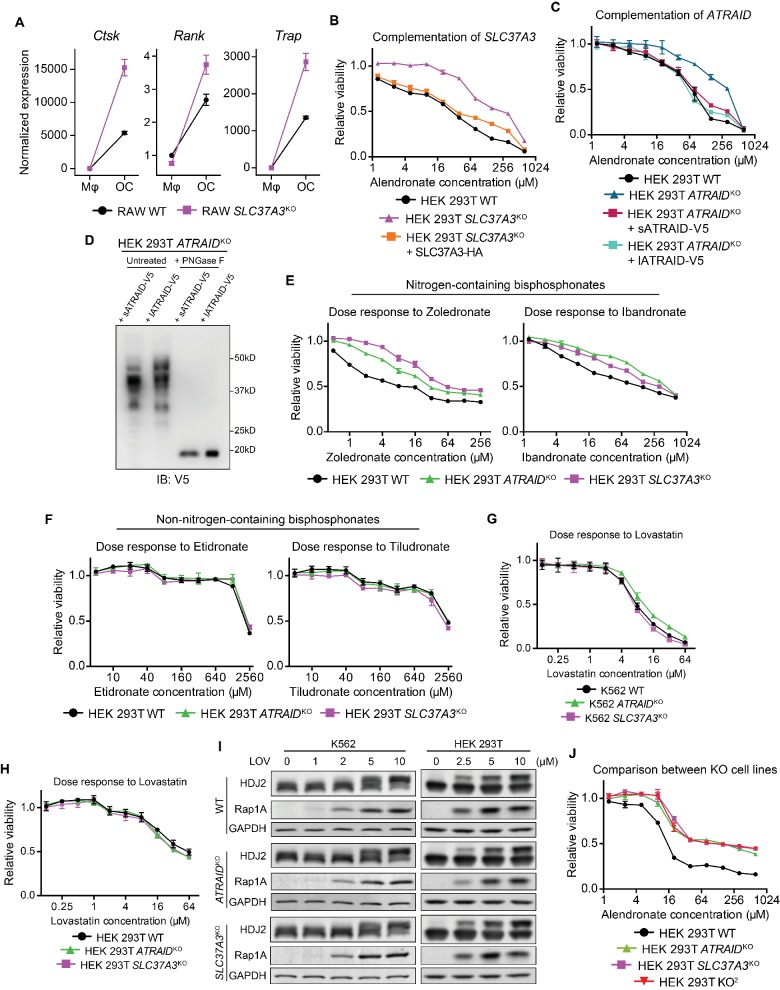
Additional evidence that validates SLC37A3 and ATRAID as functionally related genes required for the mechanism of action of N-BPs.(A) Expression of osteoclast markers (Ctsk, Rank and Trap) in undifferentiated RAW macrophages (Mφ) and differentiated RAW osteoclasts (OC), demonstrating successful differentiation of RAW cells. (B–C) Dose responses to alendronate in SLC37A3KO or ATRAIDKO HEK 293 T cells complemented with epitope tagged SLC37A3 or ATRAID, respectively, compared with those in wild-type, ATRAIDKO and SLC37A3KO cells. (D) Immunoblot comparing the short isoform of ATRAID (sATRAID) with the long isoform of ATRAID (lATRAID), showing that the long isoform of ATRAID is expressed as the same protein as the short isoform of ATRAID. Note that unequal amount of protein was loaded in each lane to obtain even exposure. The amount of protein loaded from left to right was: 100 µg, 40 µg, 10 µg and 4 µg, respectively. (E–F) Dose response curves of wild-type, ATRAIDKO and SLC37A3KO HEK 293 T cells to nitrogen-containing bisphosphonates (E) and non-nitrogen-containing bisphosphonates (F). (G–H) Dose response curves of wild-type, ATRAIDKO and SLC37A3KO K562 cells (G) and HEK 293 T cells (H) to lovastatin. (I) Immunoblots measuring lovastatin-induced reduction in protein prenylation in wild-type, ATRAIDKO and SLC37A3KO K562 cells and HEK 293 T cells. (J) Dose response to alendronate in KO2 HEK 293 T cells, compared with those in wild-type, ATRAIDKO and SLC37A3KO cells. For (B–C), (E–H) and (J), data depict mean with s.d. for biological triplicate measurements. LOV: lovastatin. KO2: ATRAIDKO; SLC37A3KO. PNGase F: peptide: N-glycosidase F, an enzyme that removes asparagine (N)-linked sugar modifications on glycoproteins.